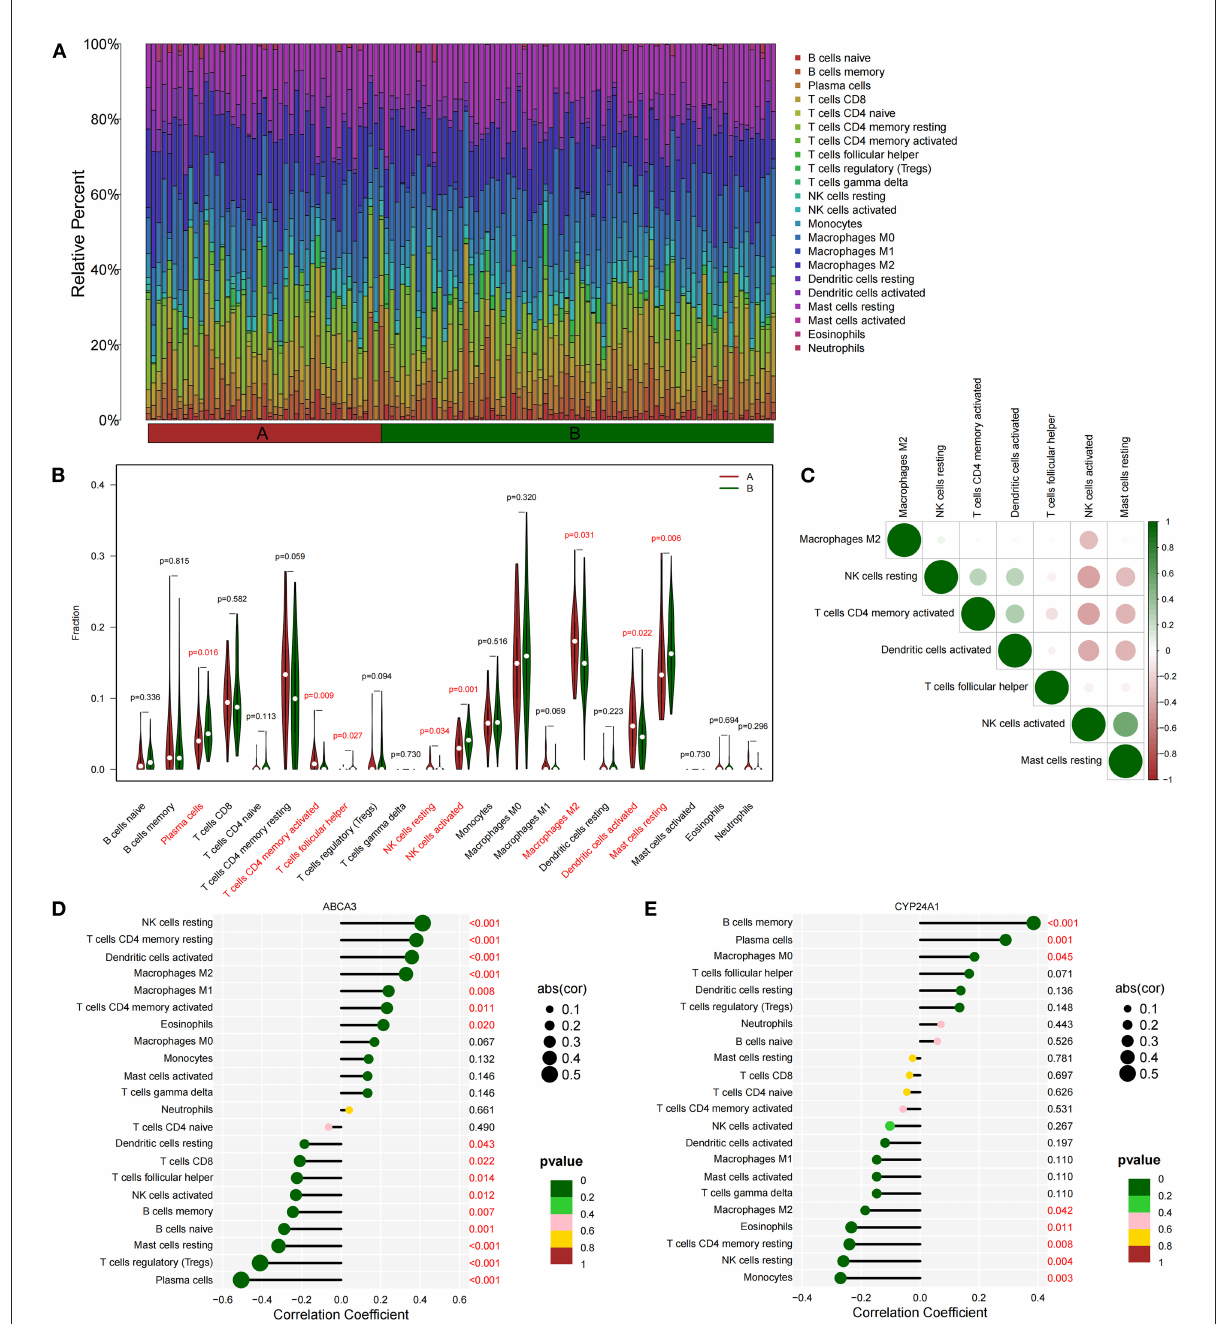
FIGURE5 Immune cell infiltration between subtypes. (A) Immune microenvironment of subtypes A and B. (B) Differences in immune cell infiltration among subtypes. (C) Correlation heat maps of immune cells with differences. (D) Correlation between ABCA3 gene expression and immune cell infiltration. (E) Correlation between CYP24A1 gene expression level and immune cell